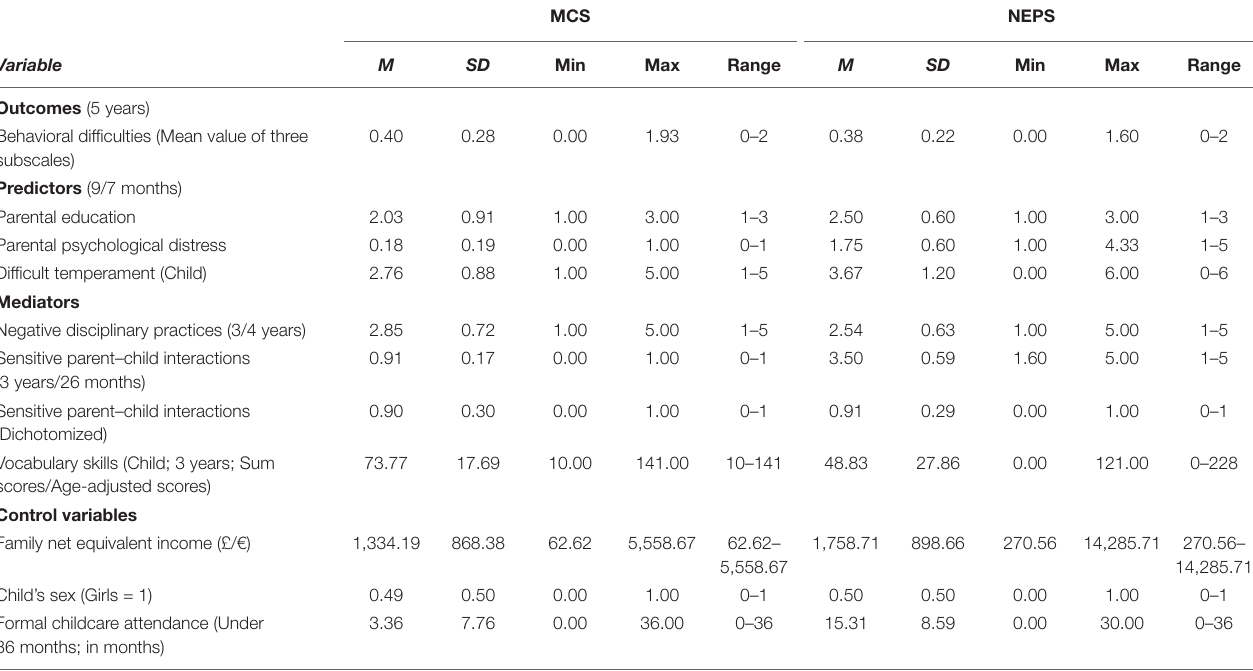
TABLE 1 | Descriptive statistics of study variables (MCS: N = 13,053; NEPS: N =